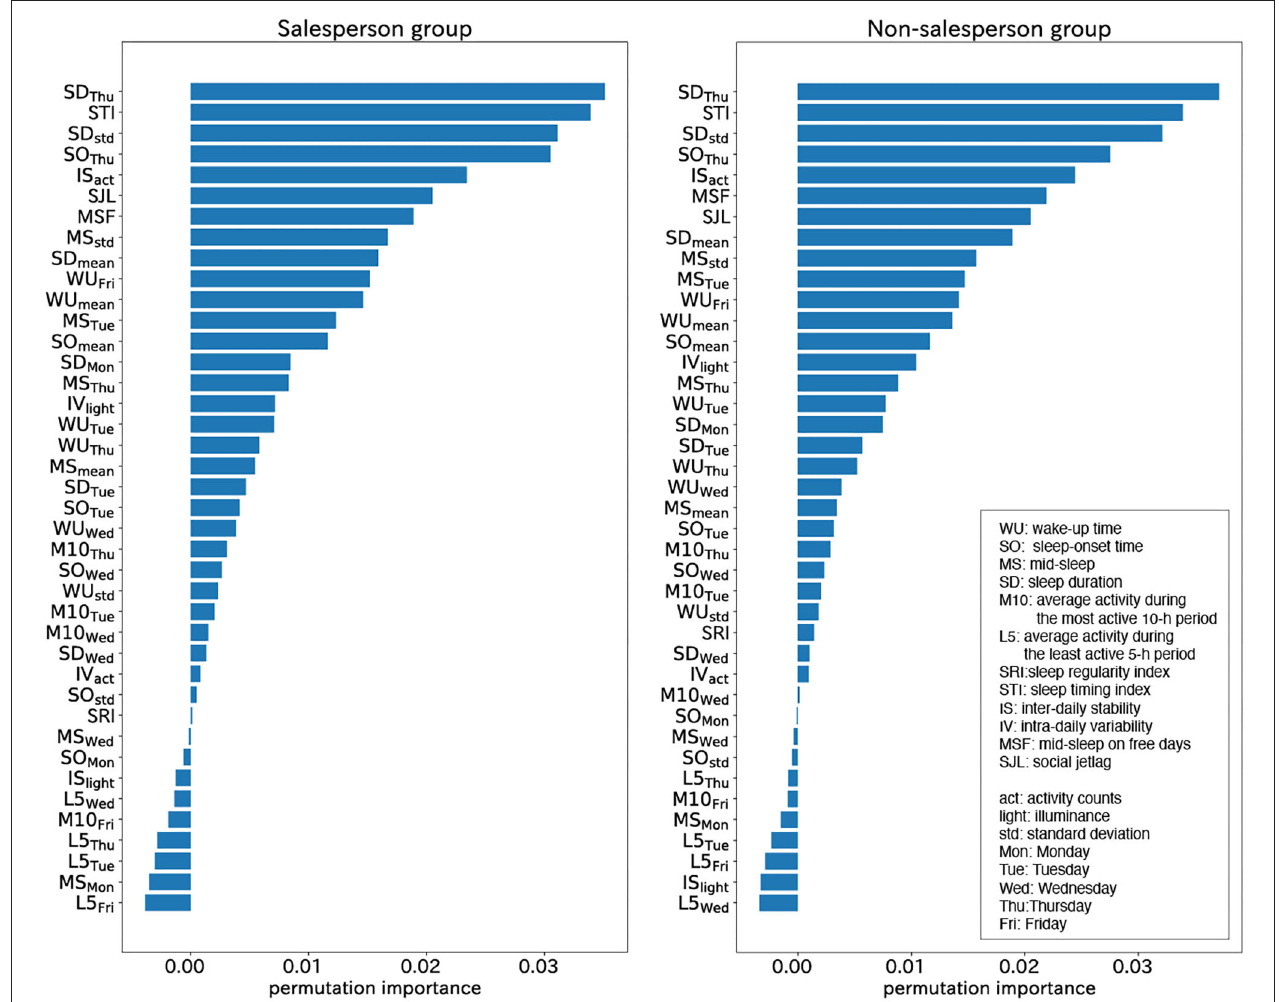
FIGURE 7 | Permutation importance calculated from salesperson group (left) and non- salesperson group (right): the top five WSD factors were the same. The factors of WSD were not related to specific occupational